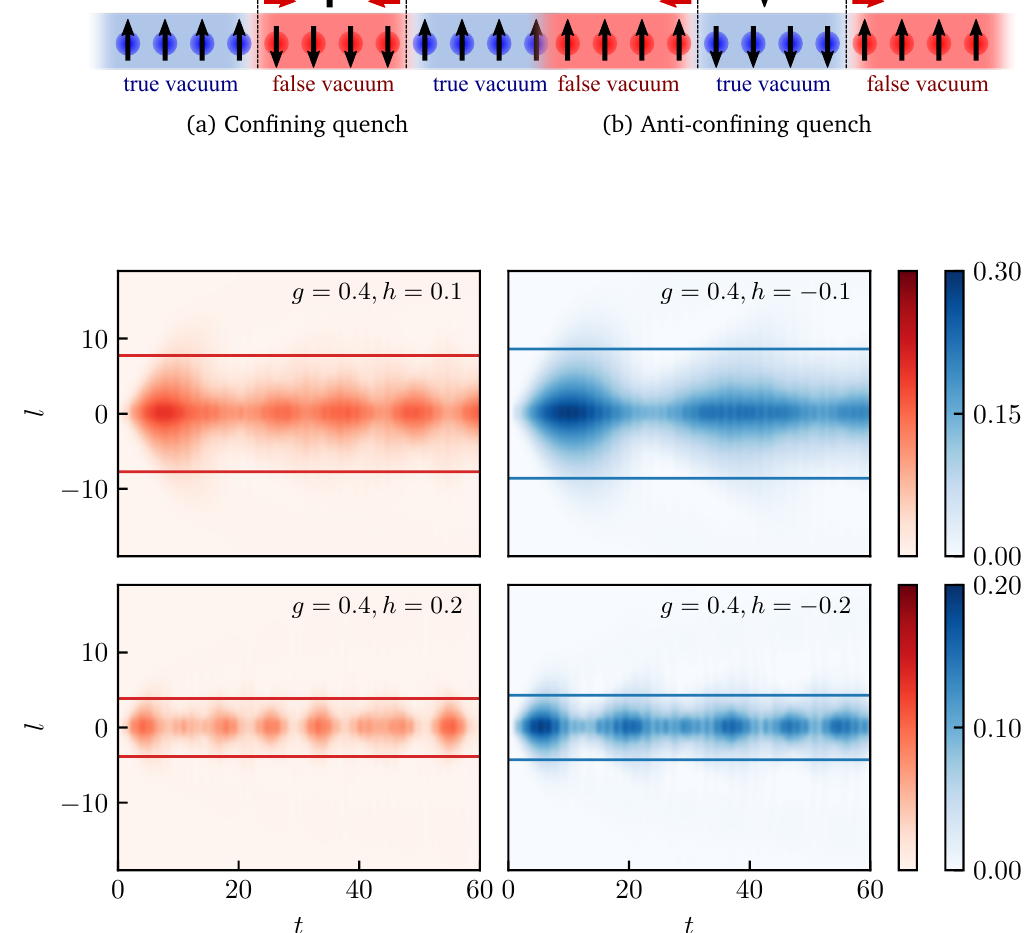
Figure 1.1: Upper panel: (a) For h parallel to the initial magnetisation, bubbles nucleated during the quench contain the false vacuum. The corresponding attrac- tive forces (red arrows) confine domain walls into ‘mesons’. (b) For h opposite to the initial magnetisation, nucleating bubbles contain the true vacuum. The induced repulsive forces (red arrows) accelerate the domain walls. Lower panel: Time evo- lution of the connected spin-spin correlation function C g = 0.4 in the confining regime, h > 0 (left), and in the anti-confining regime, h < 0 (right). Red vs. blue lines show average bubble sizes estimated using Eqs. (2.15) and (2.14),